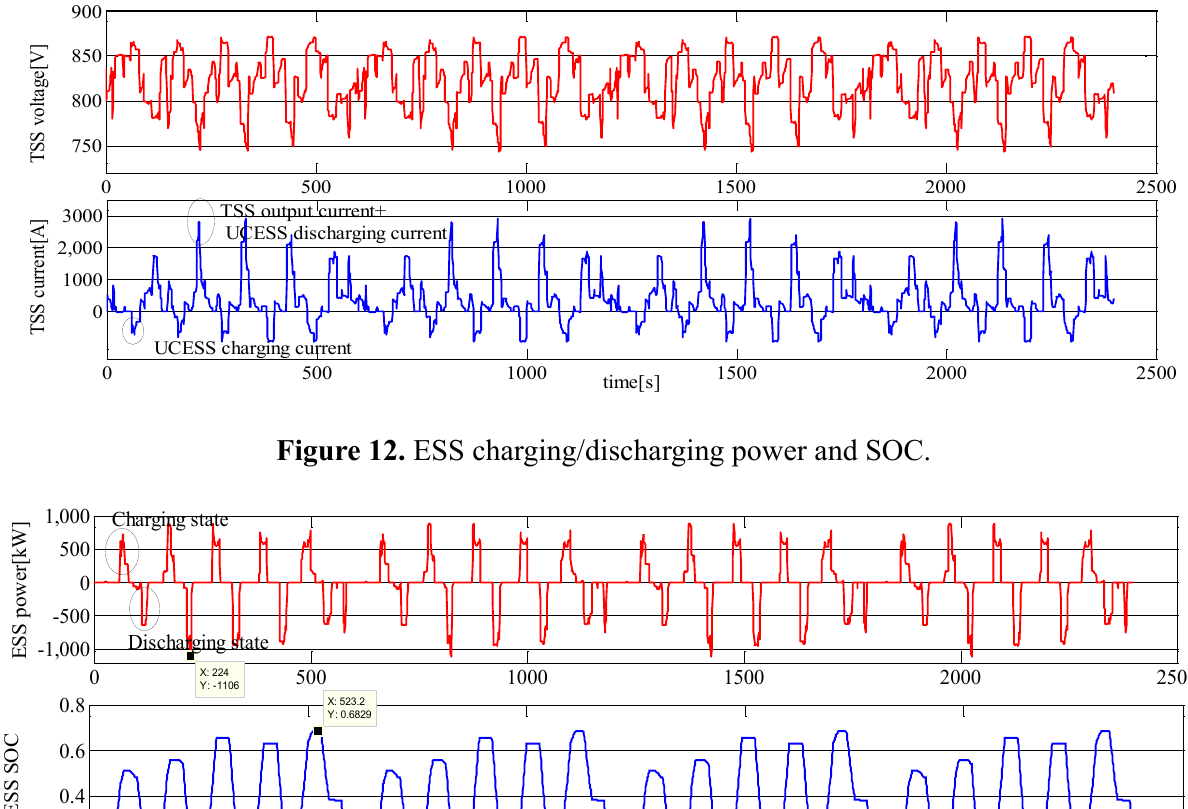
Figure 11. TSS terminal voltage and net current.